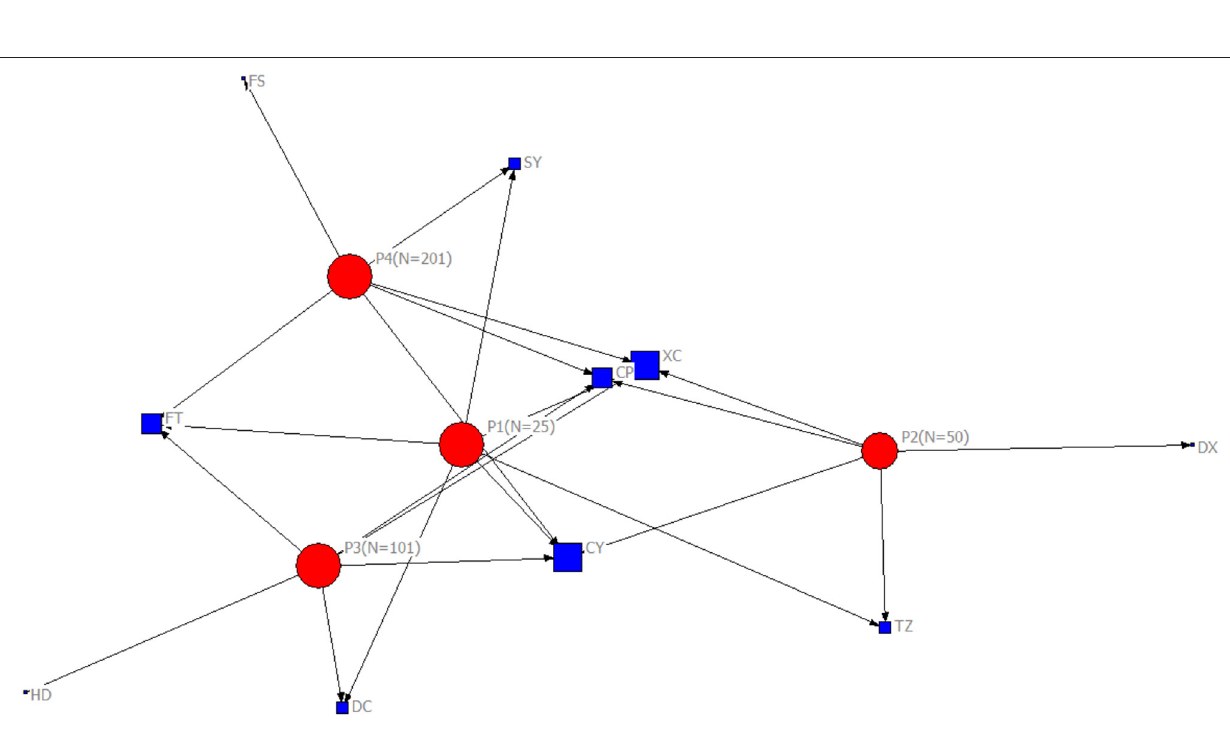
FIGURE 11 | The Location of Key Nodes in the Distribution